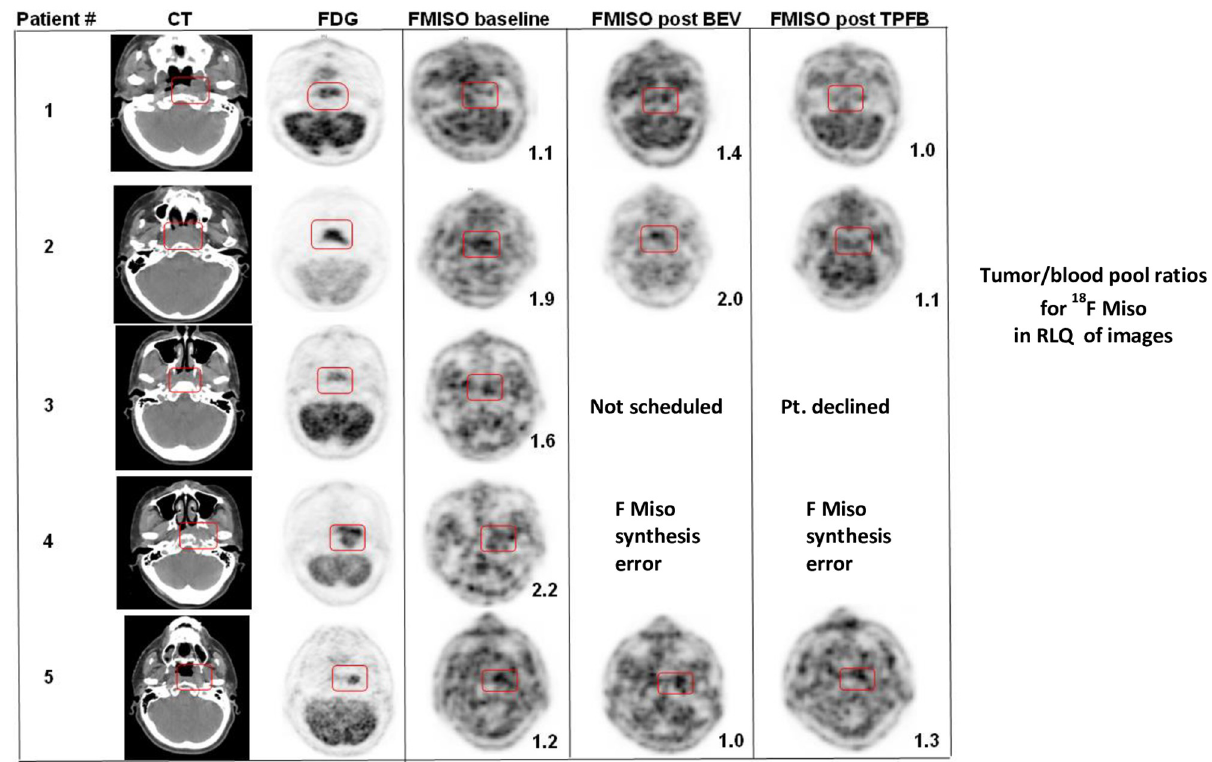
Fig 2. 18 F-MISO correlative imaging